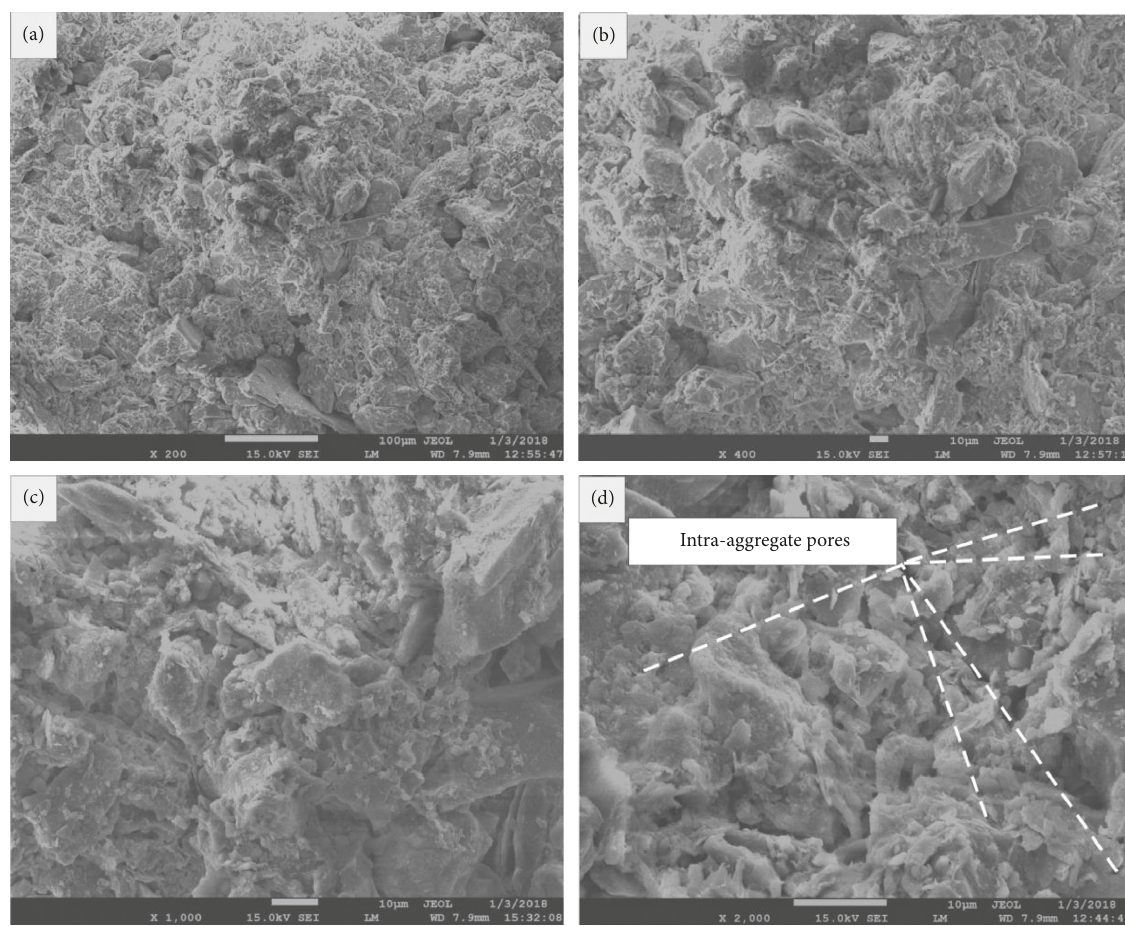
Figure 6: SEM photographs of loess compacted at optimum under different magnification: (a), (b), (c), and (d) are under magnification of 200, 400, 1000, and 2000,